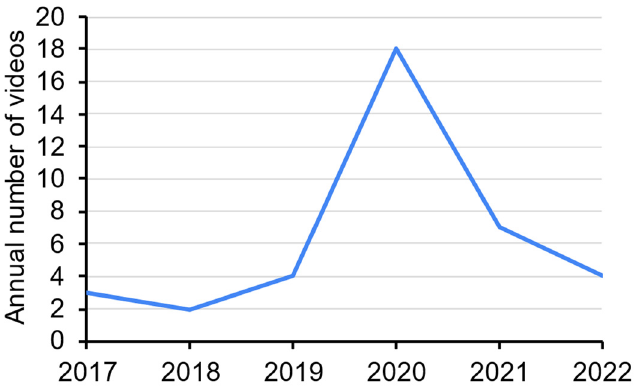
Figure 2. Number of YouTube videos uploaded each year on panoramic anatomy.